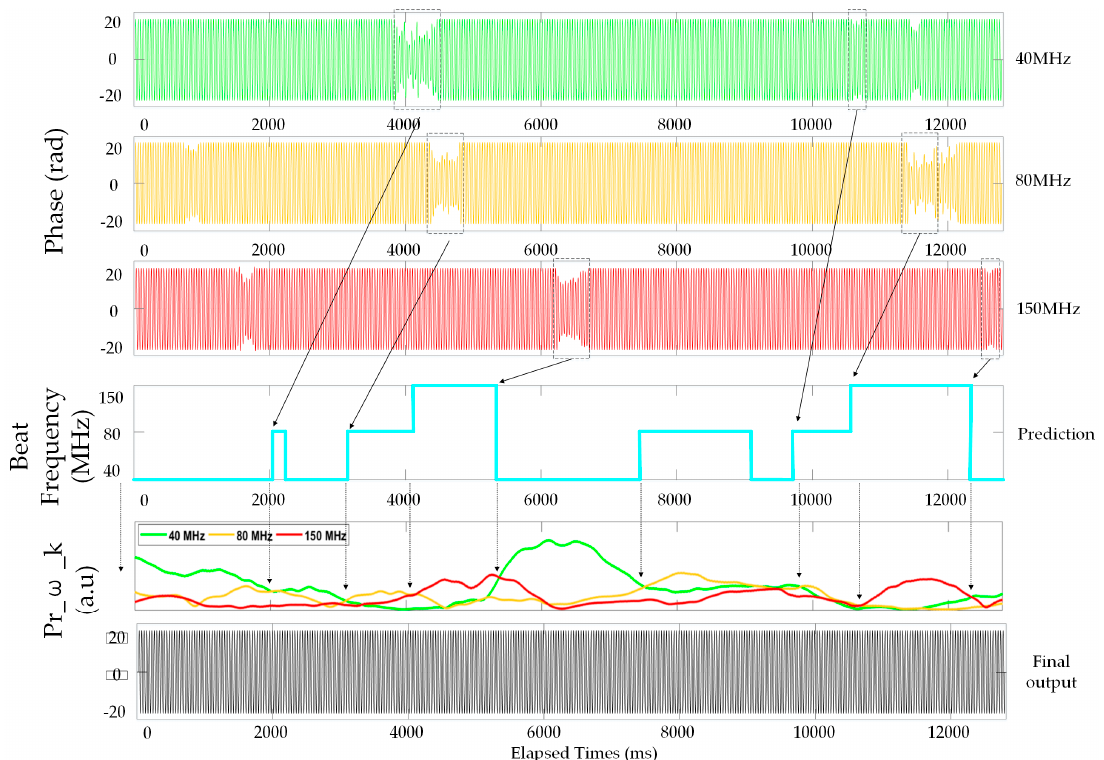
Figure 6. Extracted phase signal from all single beat frequencies, as well as prediction signal and final output.